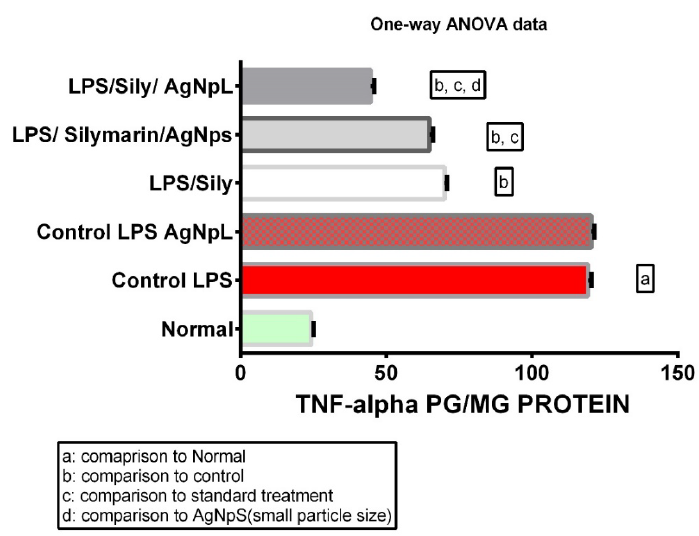
Figure 8. Expression levels of TNF- α among different groups.